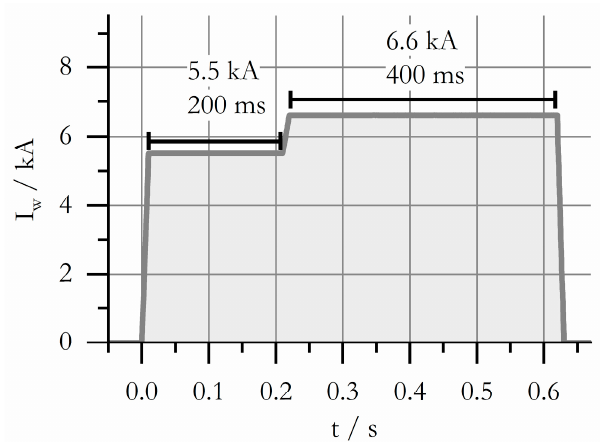
Figure 4. Welding current program used in spot welding of 22MnB5.